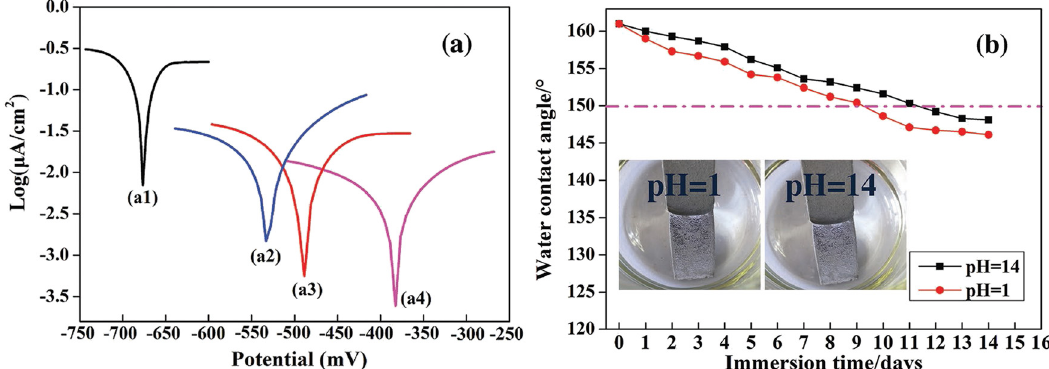
Figure 14: ( a ) PDP plots: ( a1 ) bare steel, ( a2 ) pure Al 2 O 3 , ( a3 ) Al 2 O 3 /CNTs, and ( a4 ) SHPC Al 2 O 3 /CNT/PTFE - coated samples in 3.5 wt% NaCl. ( b ) CA variation of the SHPC coating in pH 14 and pH 1 solutions as a function of immersion time [ 186 ] . Reproduced with permission from ref. [ 186 ] ; © 2017 WILEY -